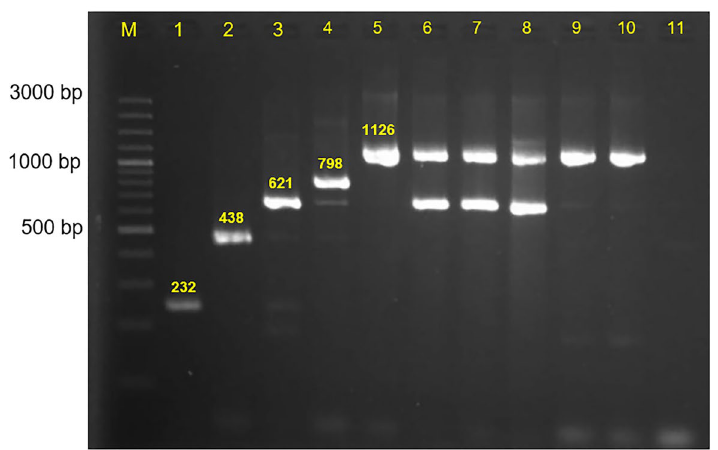
Figure 1. Agarose gel electrophoresis of PCR-amplified products of carbapenemase and mcr-1 genes from five mcr-1 -carrying E. coli and K. pneumoniae isolates. Positive control of bla IMP (lane 1), bla OXA-48-like (lane 2), bla NDM (lane 3),